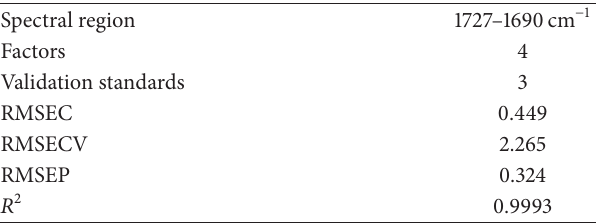
Table 1: Prediction capabilities of PLS—FTIR measurement model for the determination of FFA.